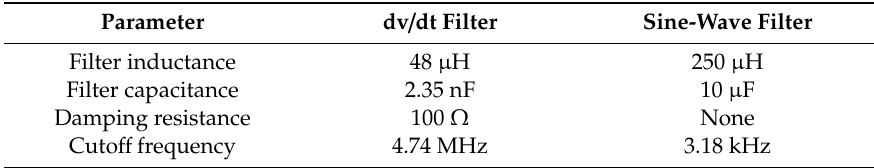
Figure 7. Time response graph considering real input signal. Table 2. Output filter parameters. Table 2. Output filter parameters.